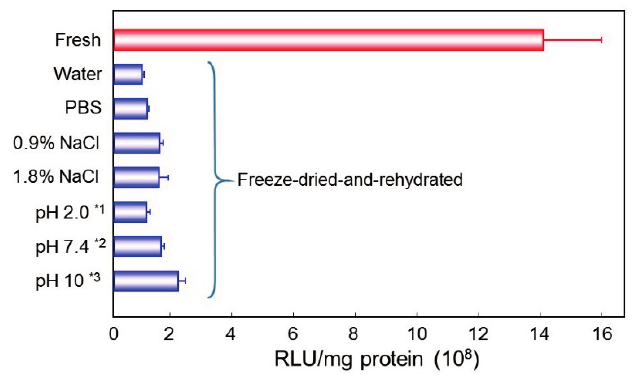
Figure 6. Gene expression by the freeze-dried DNA/(PEI “Max”)/CS complexes (1:12:8) rehydrated with various solutions. * 1 Glycine hydrochloric acid buffer; * 2 Phosphoric acid buffer (PB); * 3 Glycine sodium hydroxide